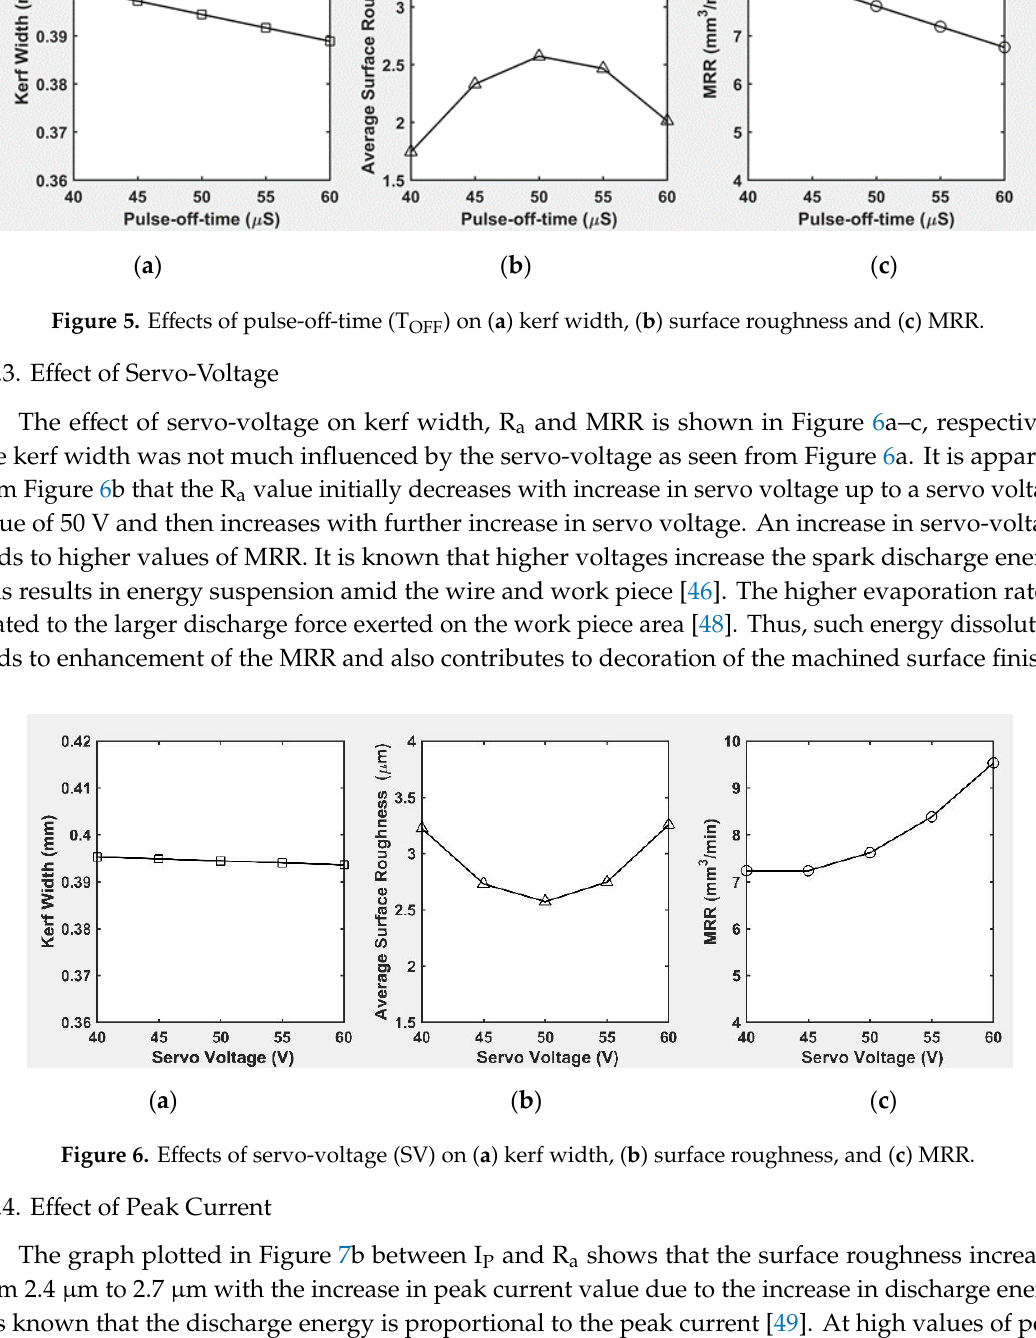
( c ) Figure 4. Effects of pulse-on-time (T ON ) on ( a ) kerf width, ( b ) surface roughness and ( c ) MRR. 3.5.2. Effect of Pulse-Off-Time From the graph plotted in Figure 5a amid T OFF and K f , it appears that T OFF has a negative impact on K f i.e., K f increases with the decrease in T OFF and vice versa. Figure 5b shows a direct positive impact between T OFF and R a . As T OFF increases, the flushing of the molten material significantly improves due to the increased time interval between two consecutive electrical discharges, thus improving the surface quality [44]. However, MRR decreases due to the reduced spark intensity at